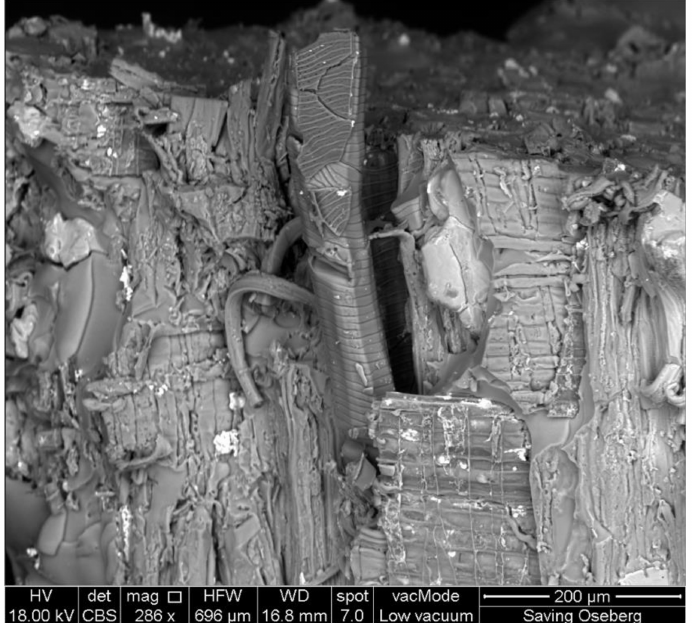
Figure 4. Scanning electron micrograph of a radial-longitudinal section from heavily degraded alum-treated wood ( Betula spp.) from the Oseberg wooden collection. Protruding in the middle of the image is a perfect casting of the lumen of a vessel member with the bars of the scalariform perforation plate indented on its surface. Attached to the casting are pieces of the actual cell wall. The wood sample was treated with a silanol-based consolidant during re-conservation trials [33]. Image: A. Zisi, © Museum of Cultural